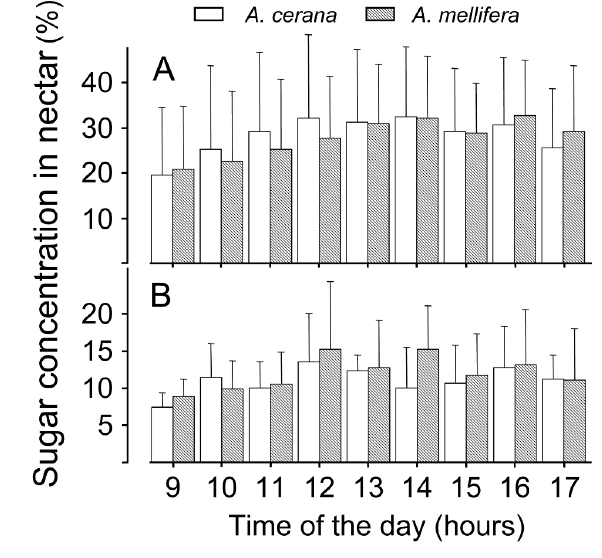
Figure 4. Sugar concentrations from crop of returning foragers of A. cerana (empty) and A. mellfiera (hatched). A: The average sugar concentrations of foragers caught each hour in both species; B: The lowest sugar concentration during each hour from foragers of both species. doi: